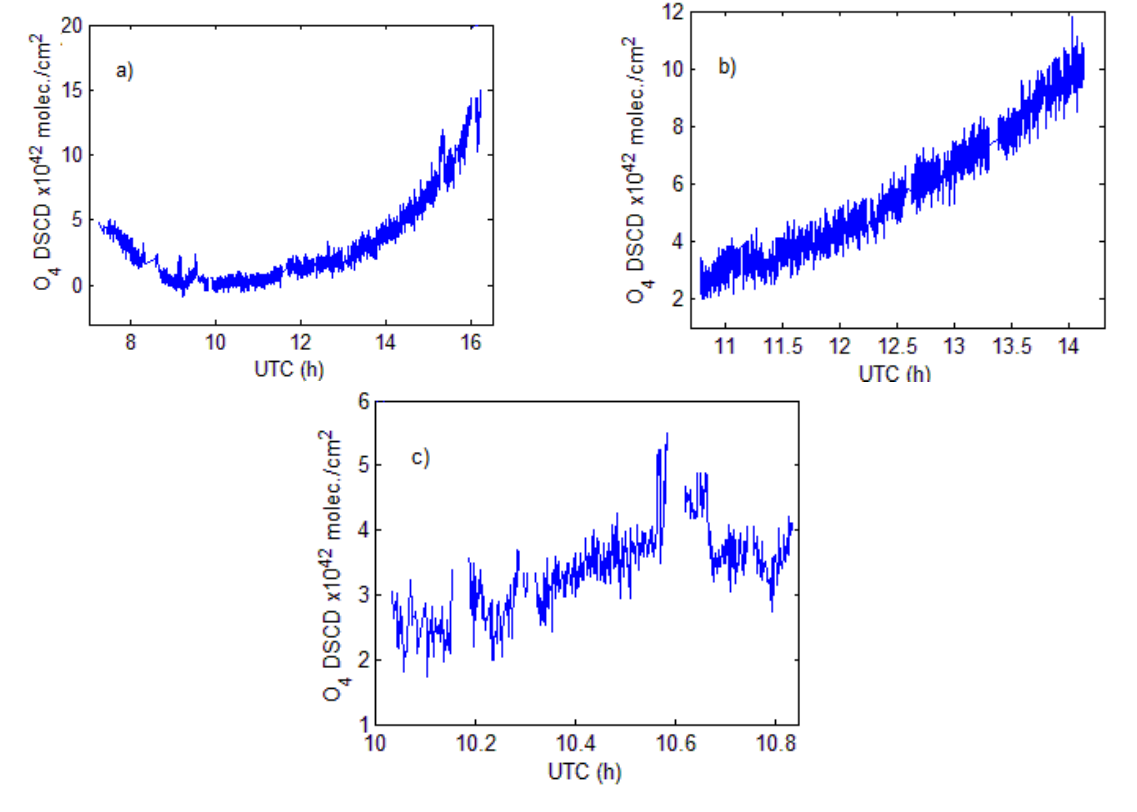
Figure 7. Diurnal variations of O DSCDs absorptions for clear sky or mostly clear sky 4 conditions on ( a ) 18 July 2011; ( b ) 28 July 2011 and ( c ) 22 August